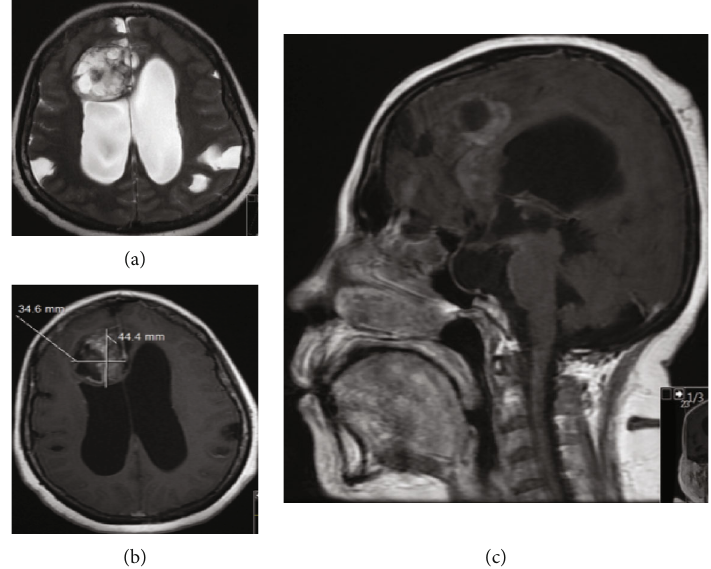
Figure 1: Axial view of a T2-weighted image with a right frontal intra-axial lesion measuring 34 × 44 mm in the transverse and anteroposterior dimensions, respectively. The lesion indents the ependymal surface of the right lateral ventricle. The lesion is heterogeneous with cystic loculations indicating necrosis; an associated bilateral ventriculomegaly of the lateral horns is appreciated (a). The lesion has a heterogeneous enhancement pattern in a T1-weighted image with contrast (b). T1 with contrast sagittal view revealing a scalloped corpus callosum with empty sella (c).